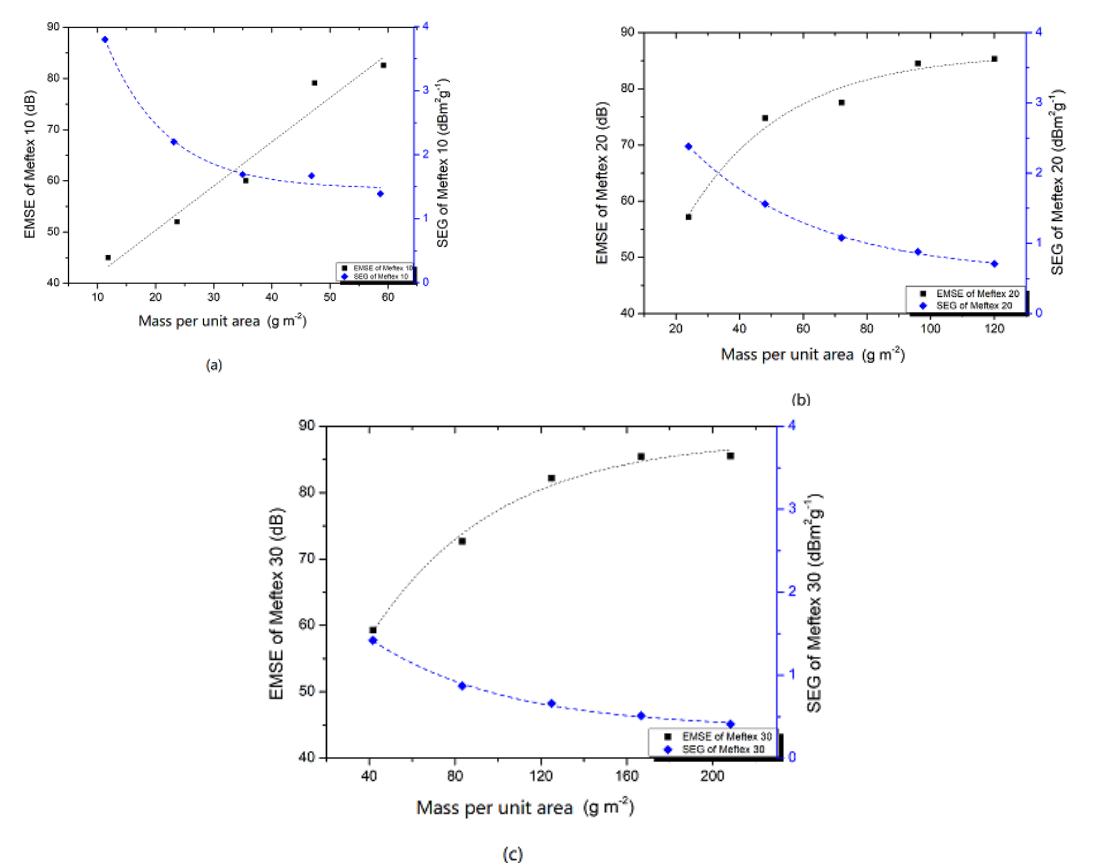
Figure 8. SEG value and relationship between SE and planner mass ( a ) MEFTEX 10 ( b ) MEFTEX 20 ( c ) MEFTEX 30.